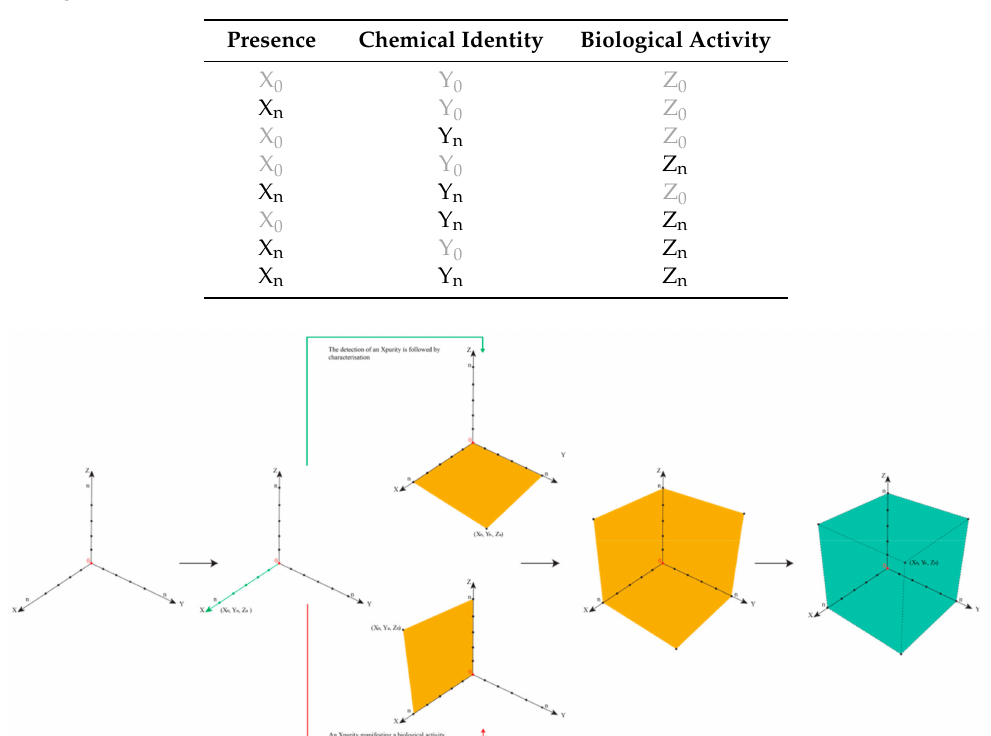
Table 2. Possible scenarios of an impurity in a drug sample or drug product with insu ffi cient information about either existence, chemistry, or biology. Grey denotes to the variables associated with missing information.